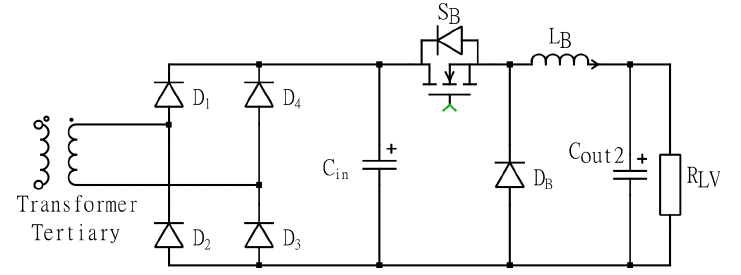
Figure 13. LLC auxiliary circuit.